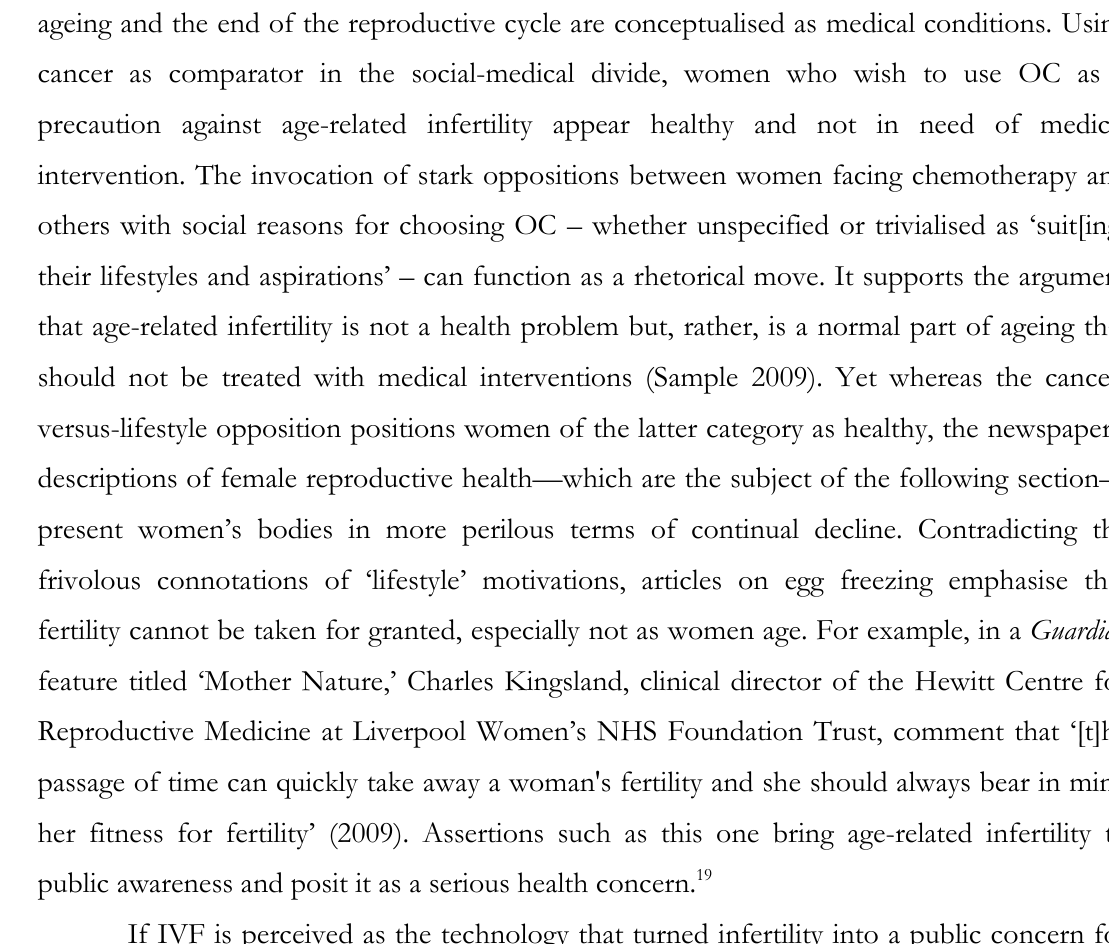
Lucy van de Wiel, For Whom The Clock Ticks: Reproductive Ageing and Egg Freezing in Dutch and British News